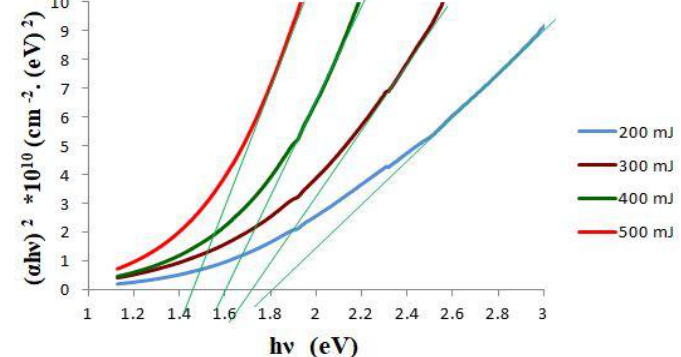
Fig.7: (αhv) 2 of the prepared PbS nanostructure as a function of the photon energy at different laser